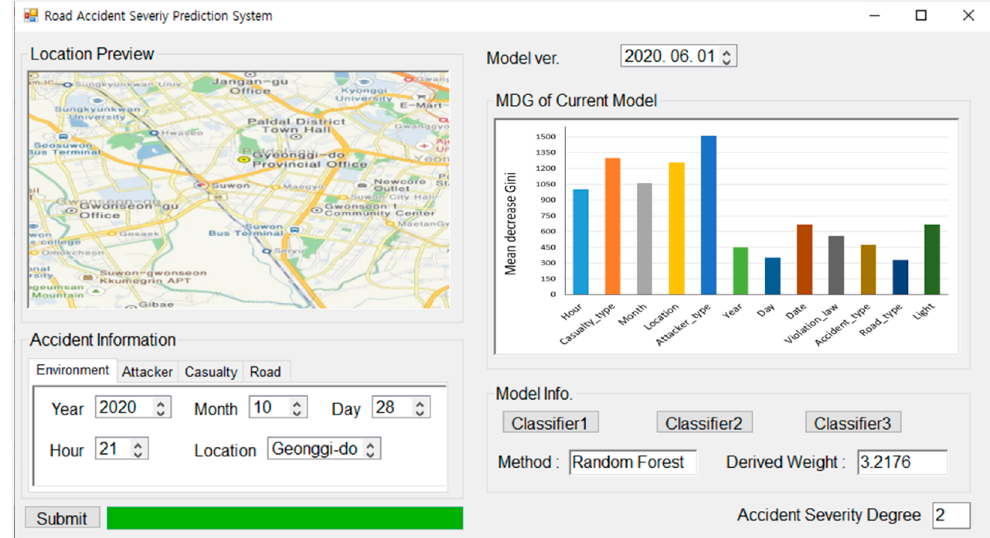
Figure 7. Traffic accident severity prediction system using weight-feedback based harmonic MDG-ensemble model.